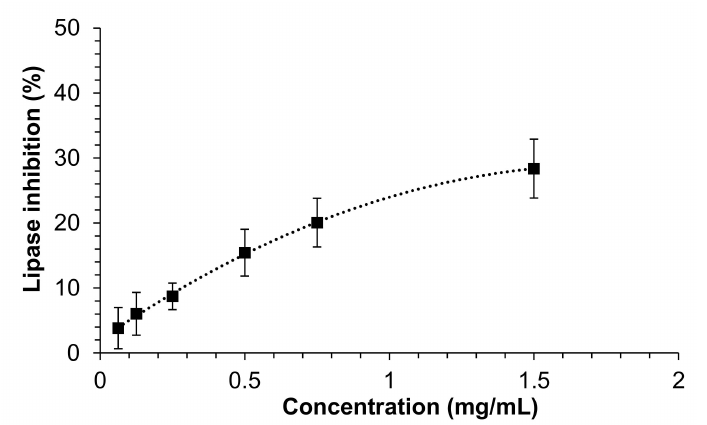
Figure 1. Effect of mealworm extract (mg/mL) on the inhibition (%) of pancreatic lipase enzyme under simulated intestinal conditions. Each data point corresponds to mean values ± SD, n = 3 independent